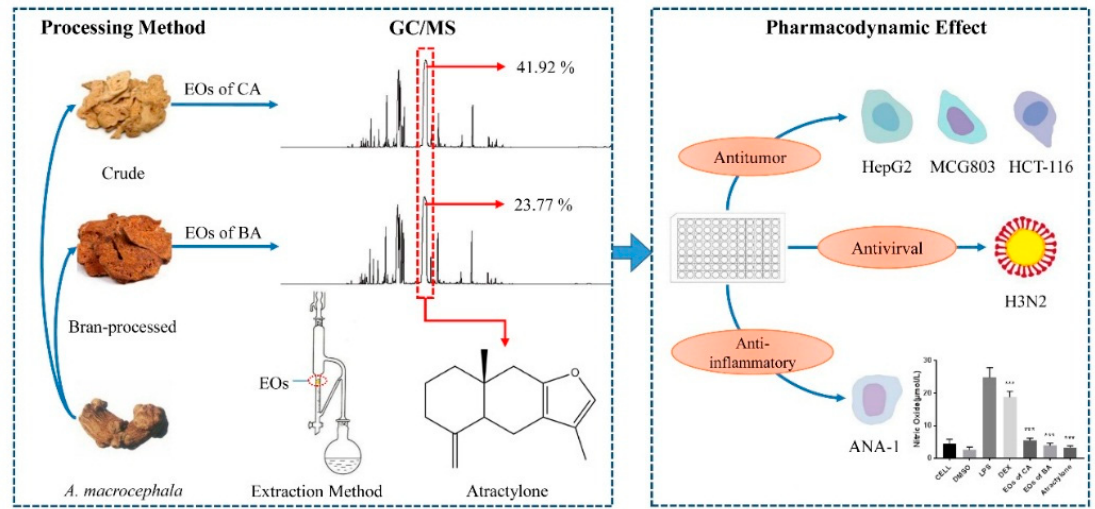
Figure 1. The relevance of chemical compositions in the EOs produced from A. macrocephala and biological activities.